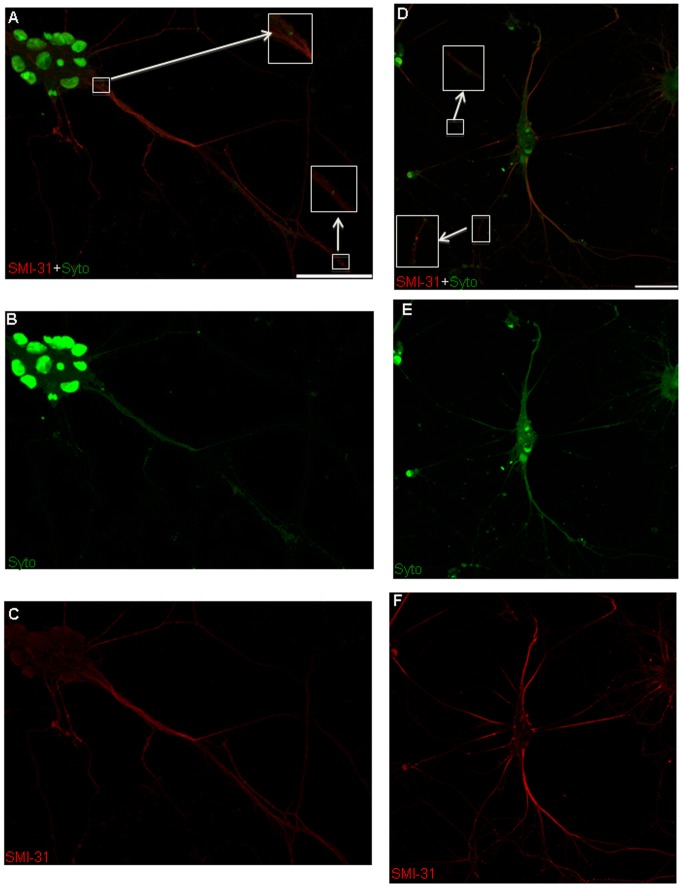
Confocal microscopy of mRNA localization in axons.(A,D) Double-label immunofluorescence shows Syto labeling in cell bodies (nuclear) and co-localization of mRNA (Syto, green) with an axonal marker (SMI-31, red). Green puncta (Syto) that are not co-labeled correspond to localization within dendrites. (Inset – expanded for more clear visualization). (B, E) Immunofluorescence of mRNA (Syto, green). (C,F) Immunofluorescence of axonal marker only (SMI-31, red). Bar is 50 µm.